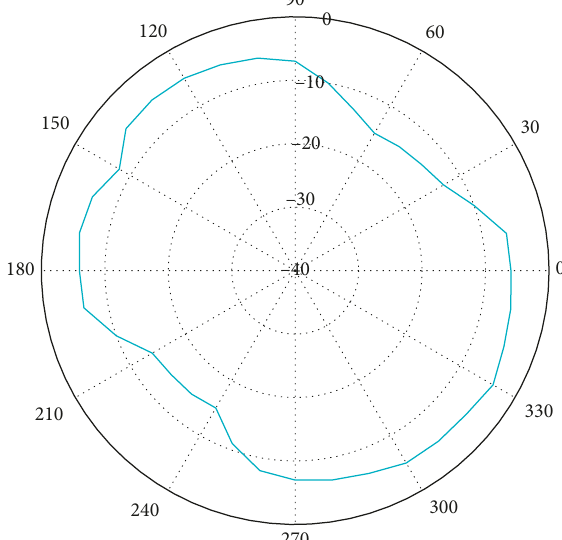
Figure 14: Emission diagram in horizontal polarization in the 3 rd plane (dbm).